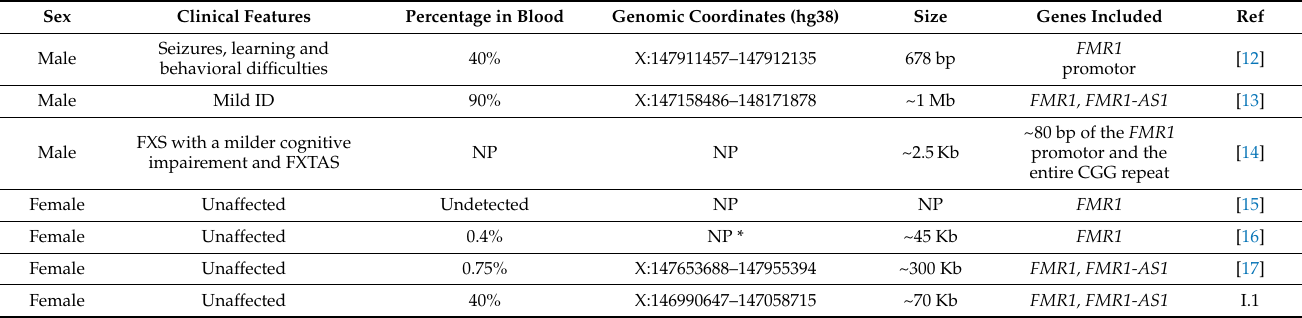
Table 1. Individuals with FMR1 gene deletions in